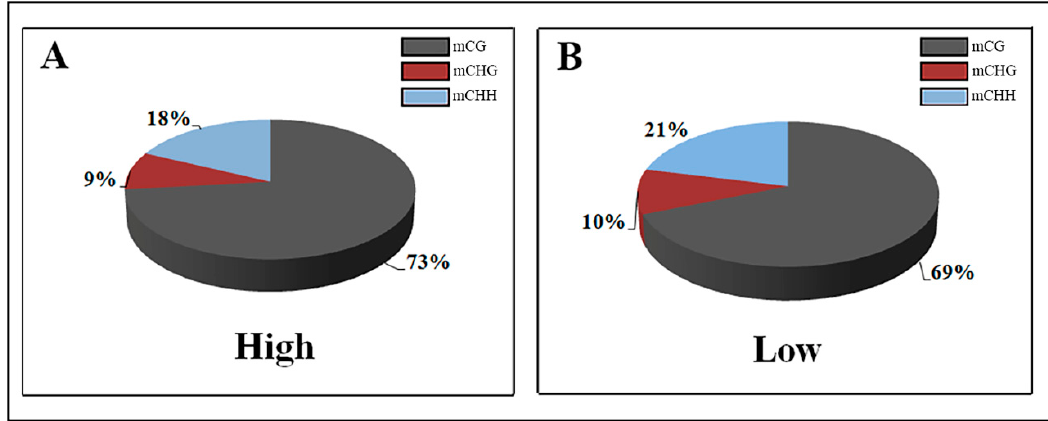
Figure 2. Comparison of DNA methylation patterns in the two high-and low-cortisol groups.